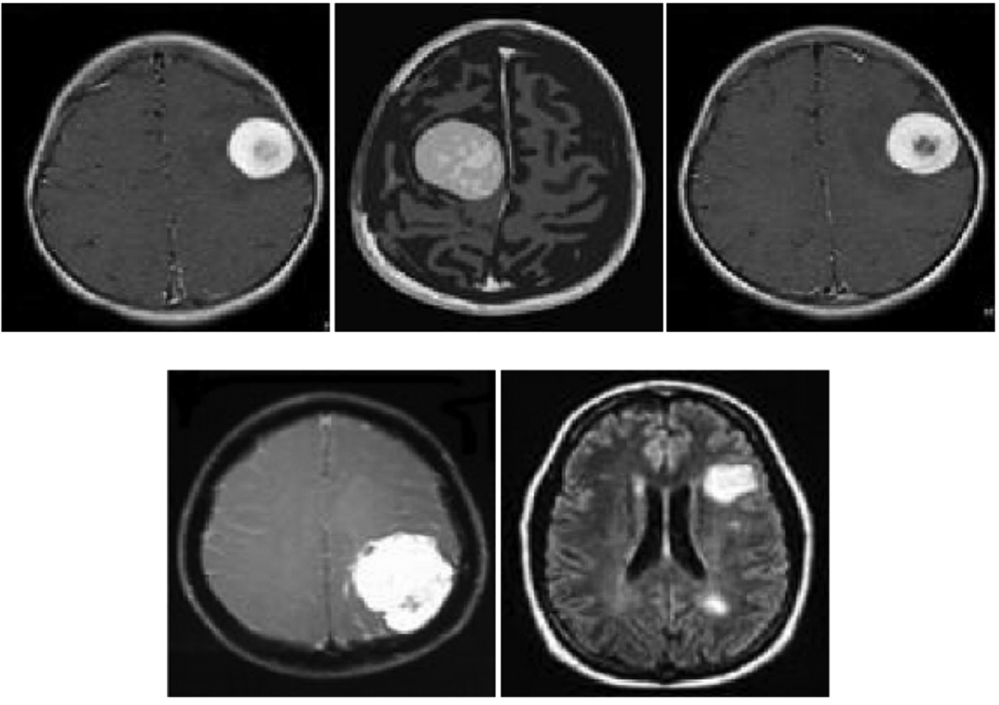
Figure 2: Experimentally Used